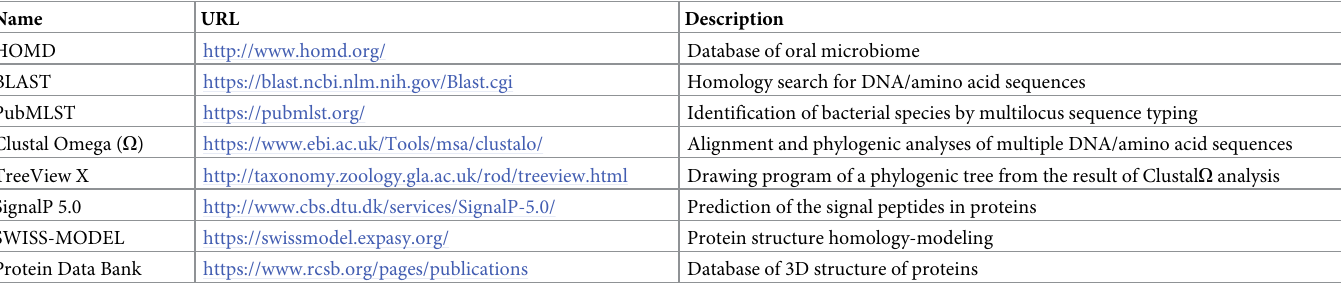
Table 2. Program and web site of bioinformatics used in this